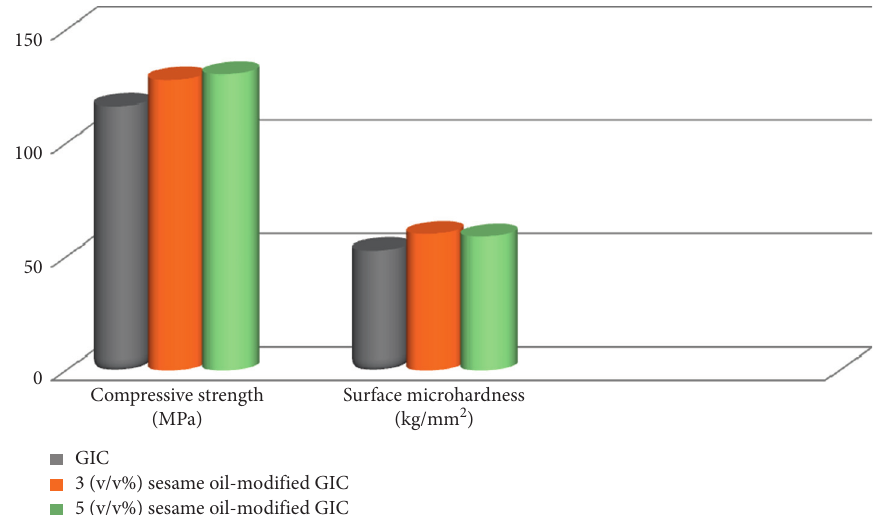
Figure 2: A graphical presentation of compressive strength, and surface micohardness of the studied